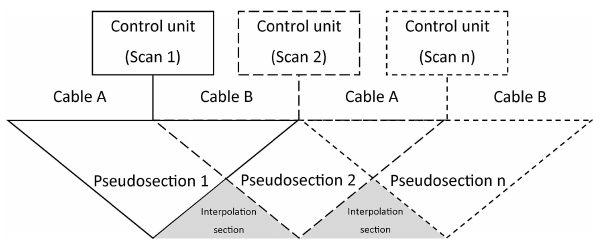
Figure 5. Measurement setup for the roll-along procedure (adapted from N El Sayed et al.,